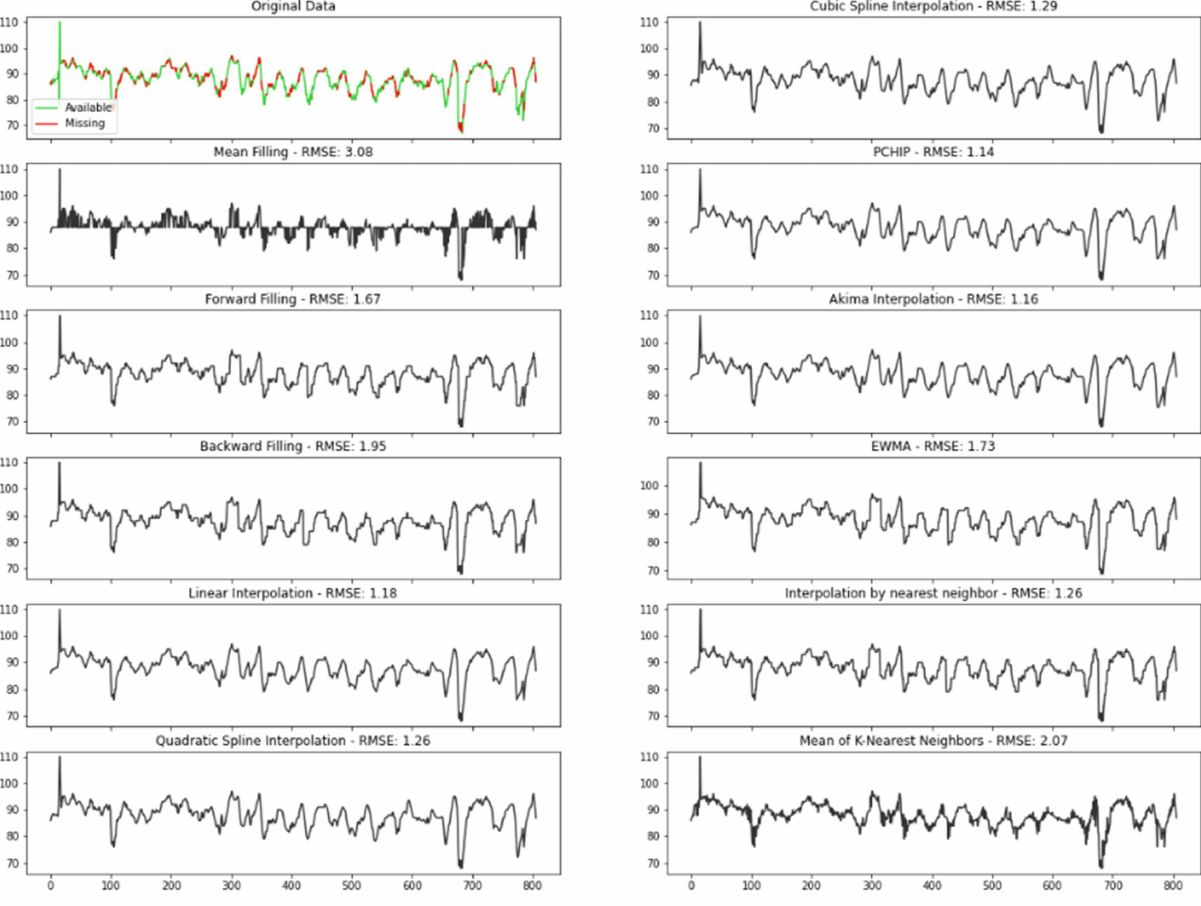
Figure 9. Comparison of the interpolation